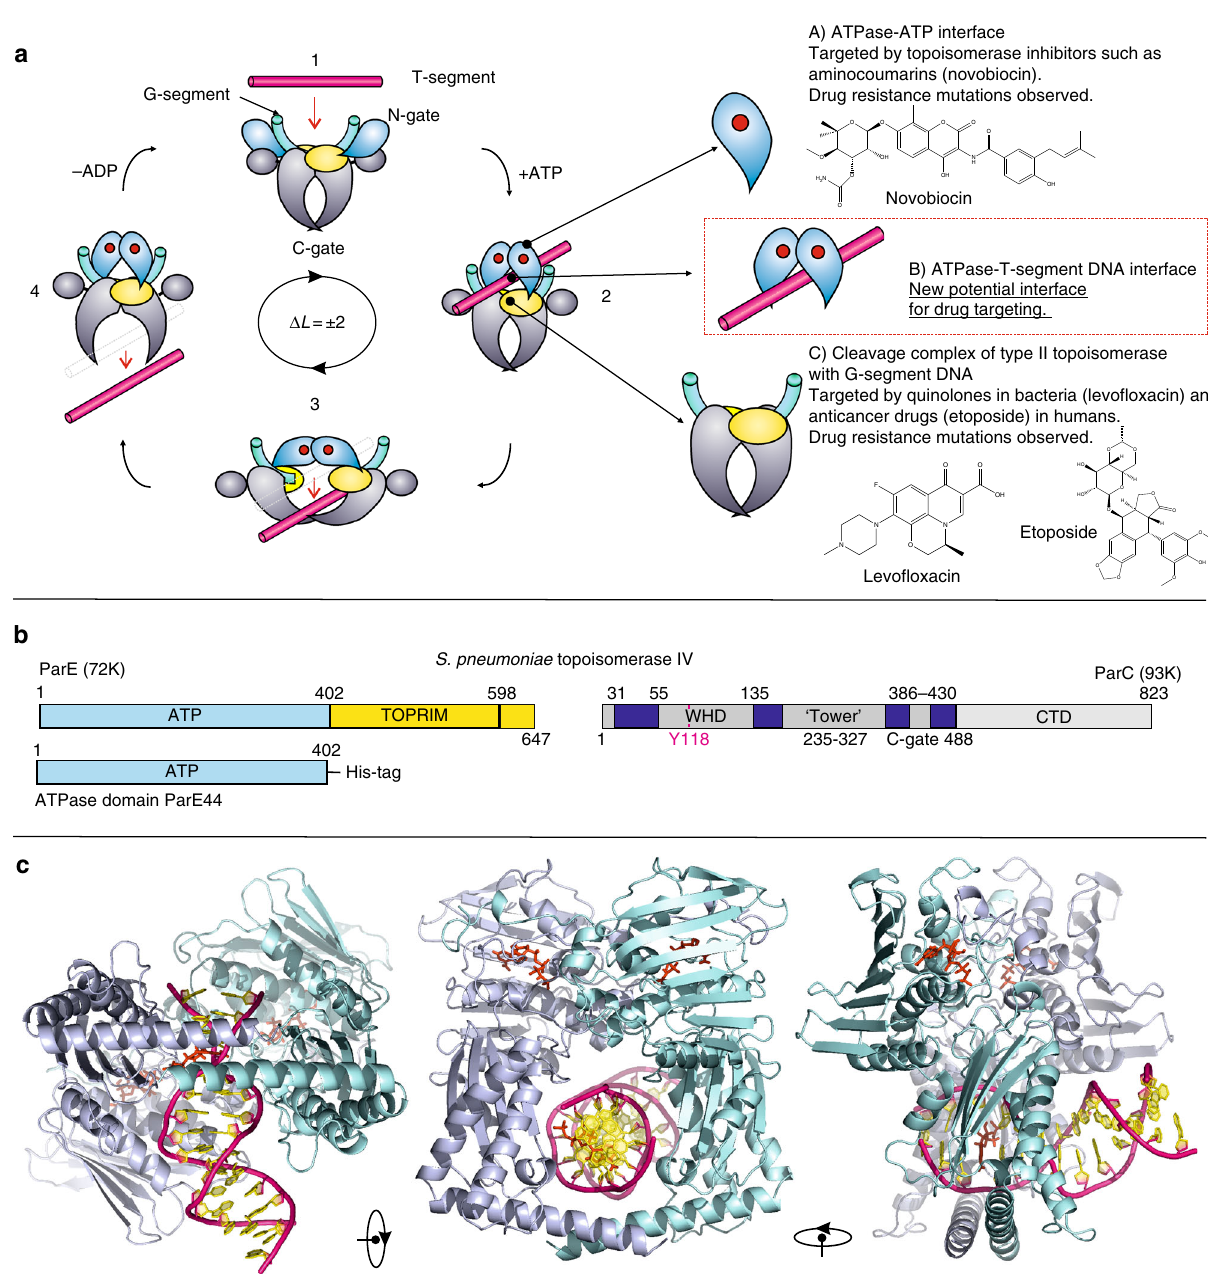
Fig. 1 T-segment DNA capture and transport by type IIA topoisomerases. a The proposed type II topoisomerase reaction cycle exempli fi ed by topoisomerase IV. ParC subunits are in grey, ParE N-terminal domain is in cyan, ParE C-terminal TOPRIM domain (containing the metal binding TOPRIM fold) is in yellow. G-gate DNA is in green and the transported T-segment DNA is in mauve. ATP bound to the ATPase domain is denoted by a red dot. Drug-targetable domains within the type II topoisomerase complex are highlighted in subsections A, B and C with examples on the right-hand side of the fi gure. b Domain organization of S. pneumoniae topoisomerase IV. The active enzyme is a ParC – 402) is 2 ParE 2 tetramer. The ATPase domain (residues 1 shown in light blue. c Orthogonal views of the ParE44 protein in complex with a captured 14-mer T-segment DNA. N-terminal ParE domains are shown in cartoon mode in light blue and cyan, bound AMP-PNP molecules are in red and T-segment DNA is in mauve/yellow for backbone/bases,